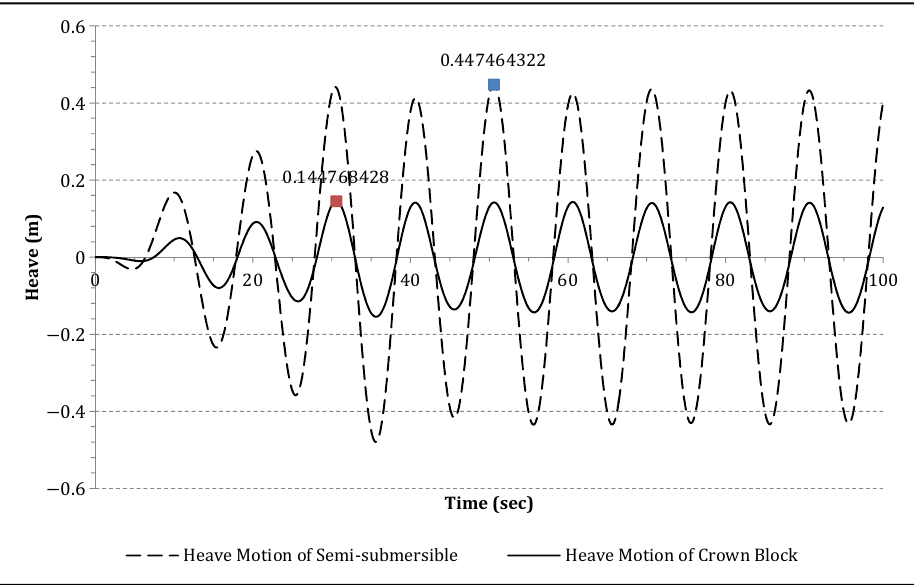
Figure 19. Heave motions of the semi-submersible and crown block for a 16.550 × 1.4-m 3 APV.